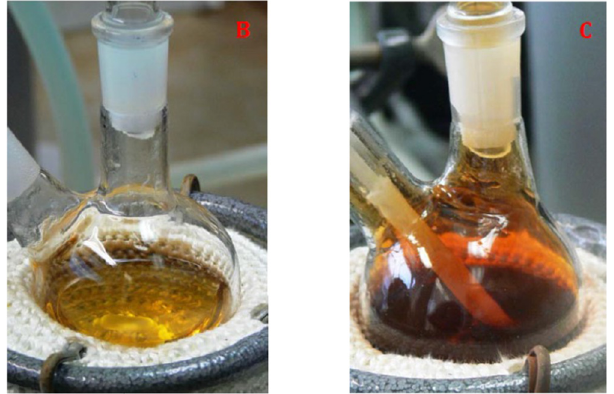
Fig. 3. Dissolution of (U 0.8 ,Pu 0.2 )C with (left) and without (right) pre-oxidation in CO 2 at 1000 ° C.